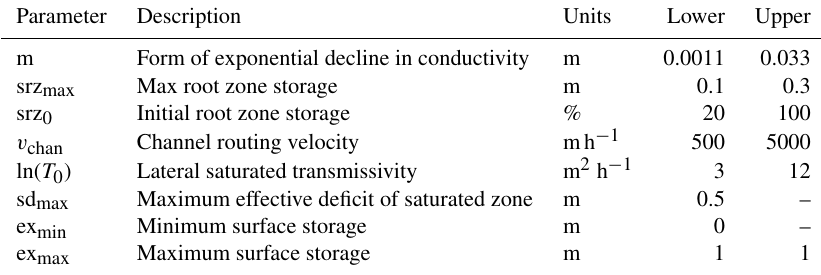
Table 1. Run-off model parameters and ranges applied in calibration and uncertainty